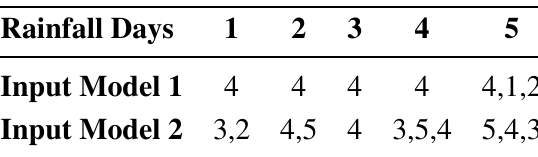
Table 2. Strips of the catchment generally (not always) producing the highest correlation coefficients in predicting freshwater levels at the Lee Maltings site where no antecedent water level information is input to the NN model.